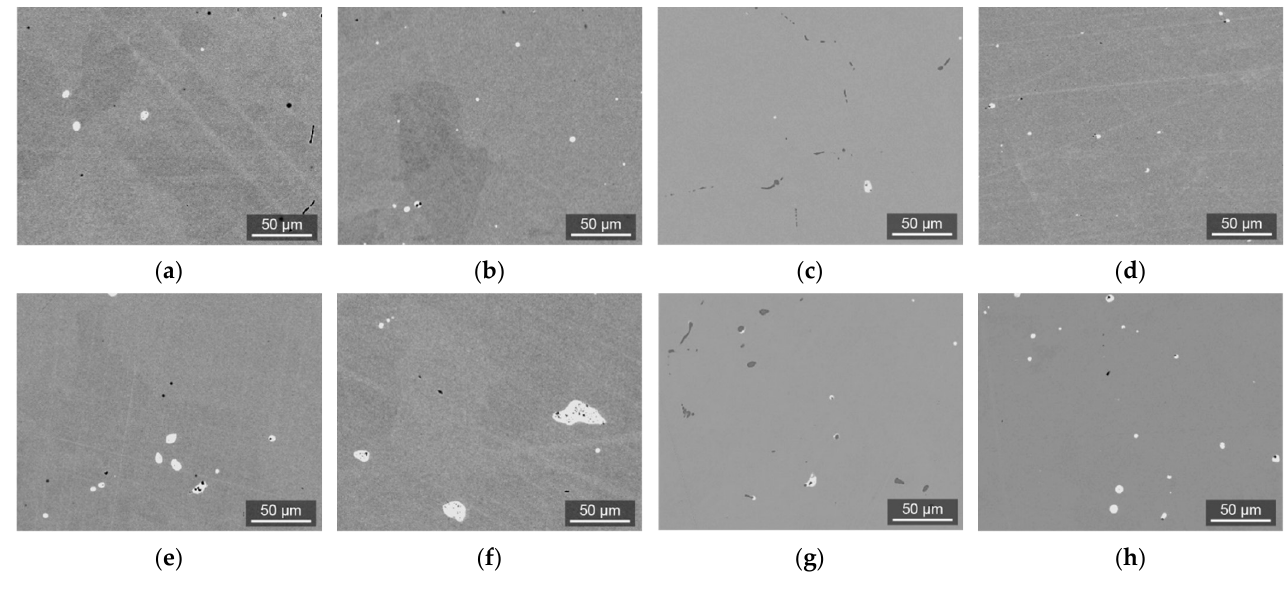
Figure 6. Manganese sulfides (dark) and bismuth (light) in the experimental ingots on the edge ( a – d ) and on central parts ( e – h ) for steel 0.4C-Cr + Bi ( a , e ), 0.4C-Cr + Bimax ( b , f ), 0.4C-Cr + Bi + S ( c , e ), and 0.14C + Bi ( d , h ).